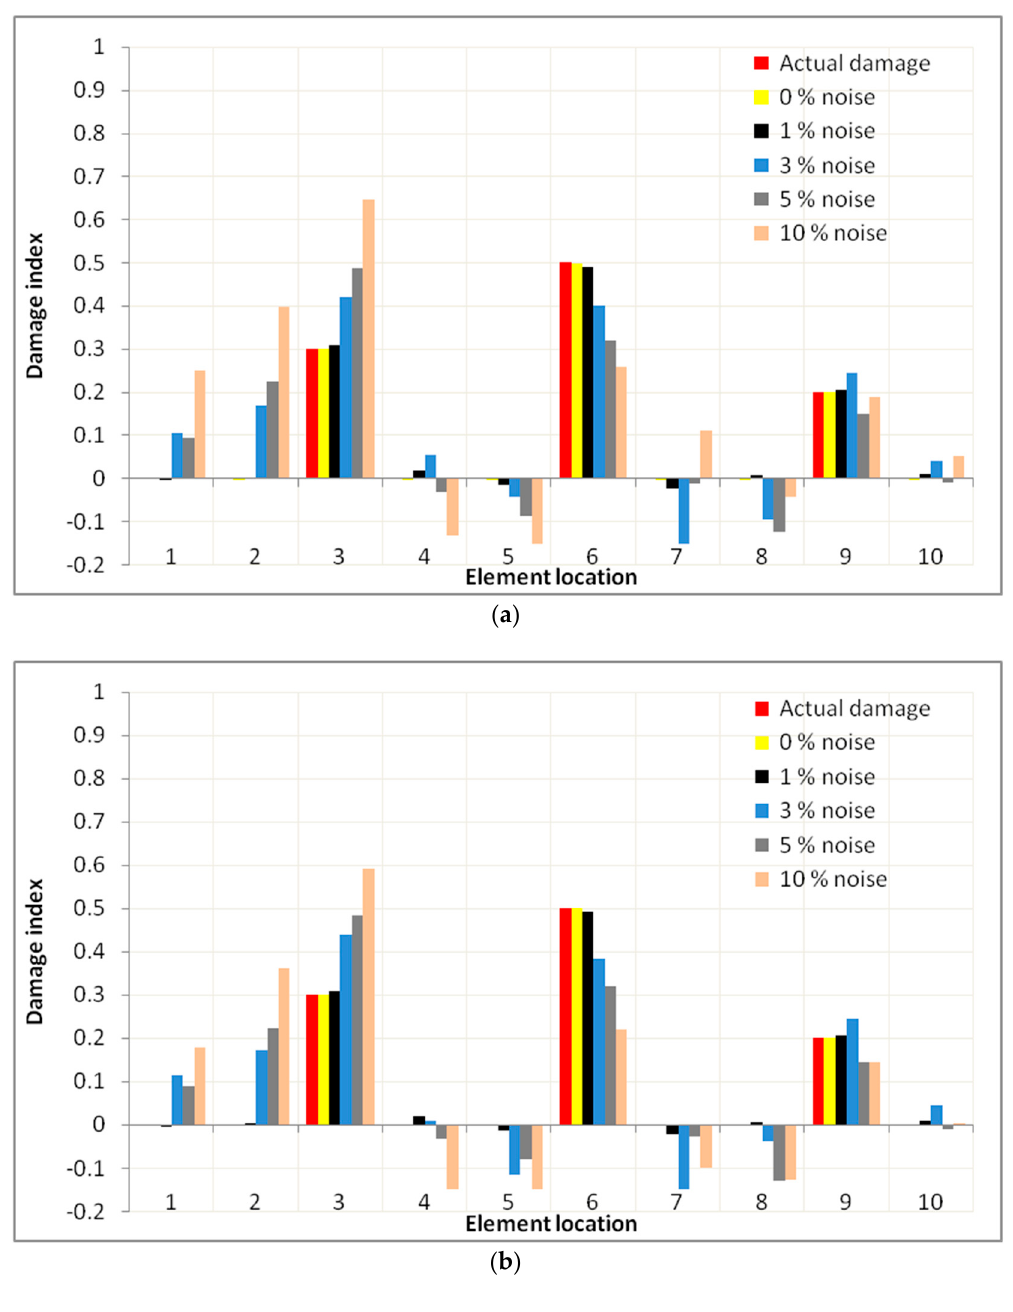
Figure 11. Damage distribution for Case 2 using Objective Function III for ( a ) noise both in frequency and mode shapes and ( b ) noise in mode shapes only.